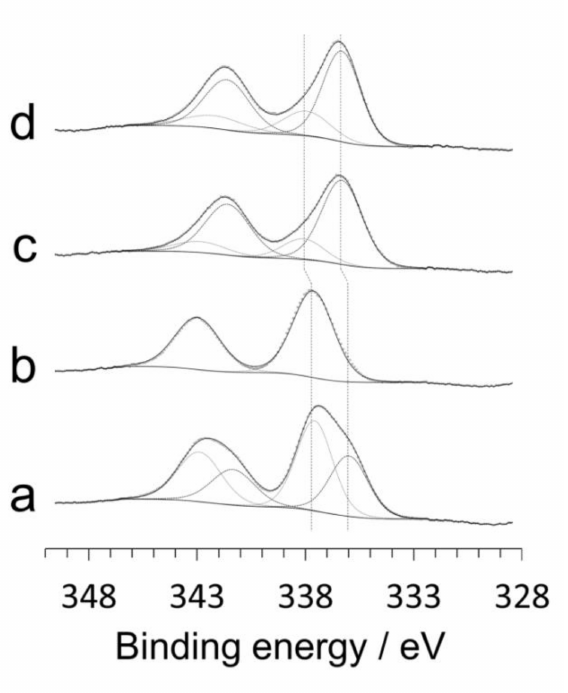
Figure 3. Pd 3d X-ray photoelectron spectra of the Pd/CeO 2 catalysts prepared by milling CeO 2 and Pd acetate ( a ) or Pd nitrate ( b ) at 50 Hz for 10 min, and catalysts prepared by incipient wetness impregnation with Pd acetate ( c ) or Pd nitrate ( d ). All catalysts contain a nominal Pd loading of 1